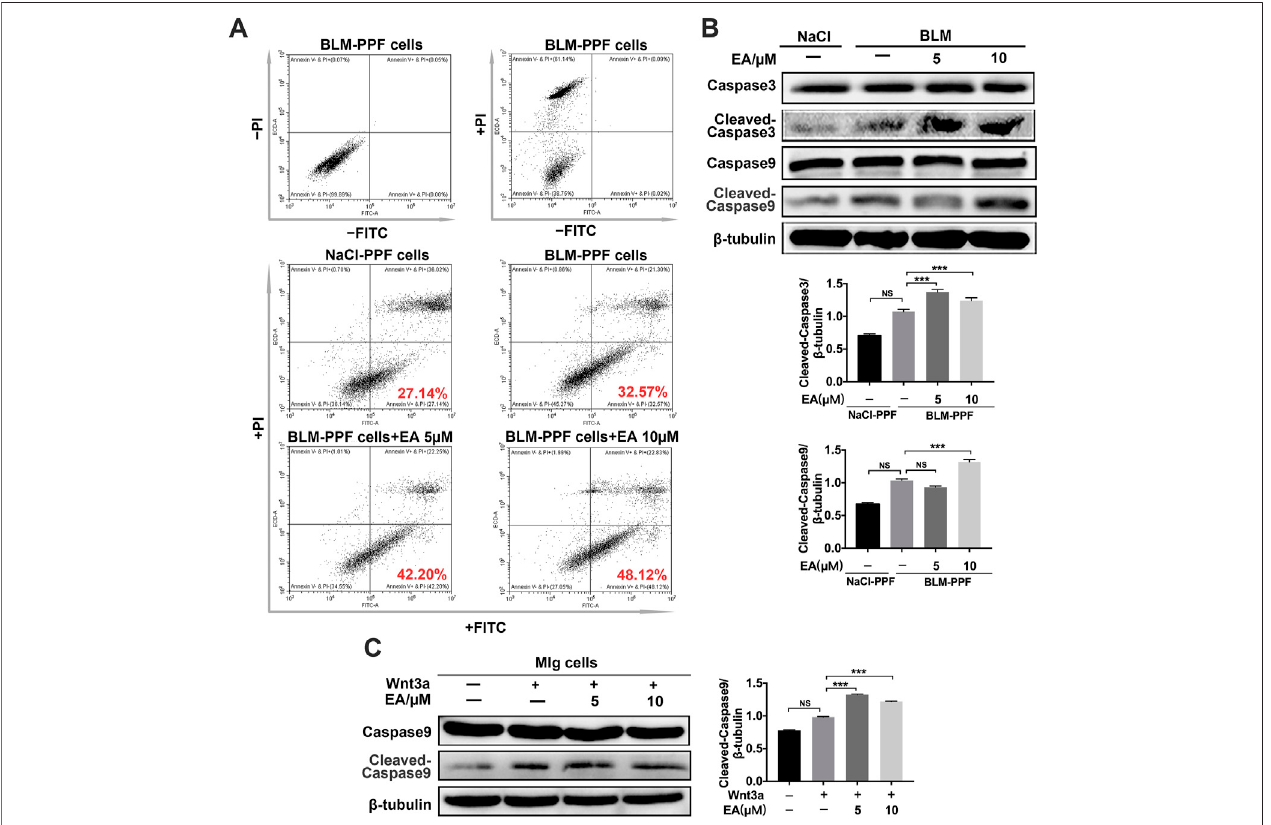
FIGURE 5| Ellagic acid promotes the apoptosis ofpulmonarymyo fi broblasts (A) BLM-PPF cells incubated with Ellagic acid (5 µM, 10 µM) and/or Wnt3a (100 ng/ ml)for24 h,andAnnexinV/PIstainingwassubsequentlyperformedtoestimateearly,lateapoptosisandnecrosisby fl owcytometry (B) BLM-PPFcellsweretreatedwith Ellagic acid (5 µM, 10 µM) for 24 h, Lysates were immunoblotted for Caspase3, Cleaved-Caspase3, Caspase9 and Cleaved-Caspase9. Densitometric analyses were shown below (C) Mlg cells were treated with Ellagic acid (5 µM, 10 µM) and/or Wnt3a (100 ng/ml) for 24 h, Lysates were immunoblotted for Caspase9 and Cleaved-Caspase9. Densitometricanalysiswereshownbeside.Datain (B , C) aremeans ± StandardErrorofMean, n (cid:1) 3,*** p < 0.001,andNS:nonsigni fi cant(one-way ANOVA). β -tubulin was used as a loading control.